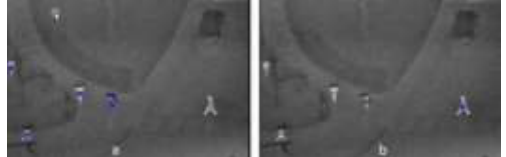
Figure 14. Dividing ROIs with possibility of presence of several pedestrians in same